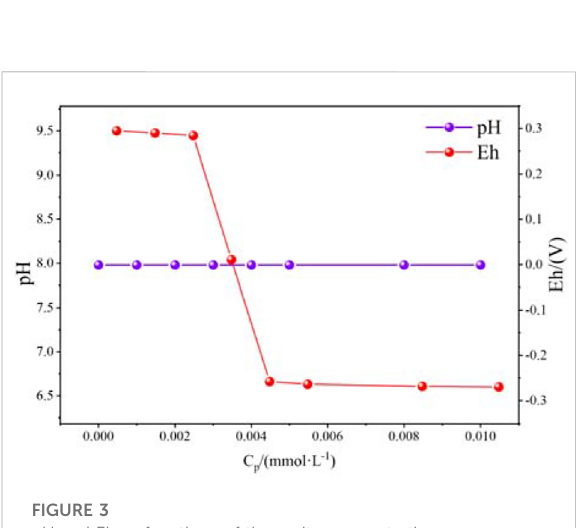
FIGURE 3 pH and Eh as functions of the pyrite concentration.